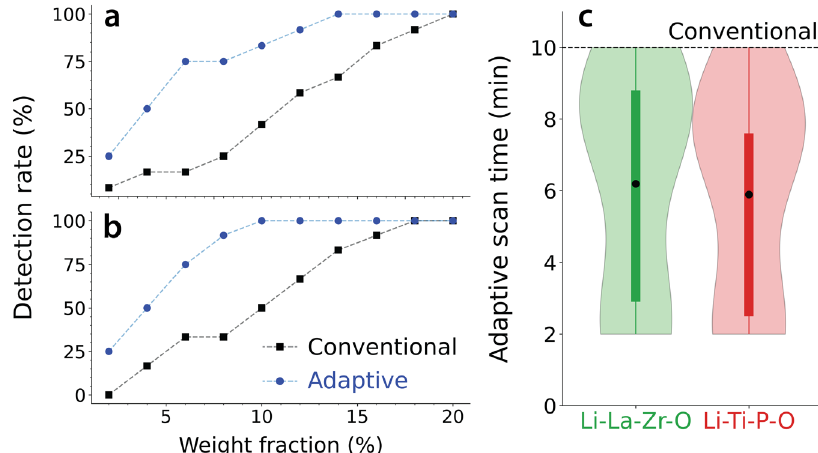
Fig. 3 Detection rates and measurement times required for impurity detection. a , b The percentage of minority phases that were correctly identi fi ed by XRD-AutoAnalyzer when applied to mixtures from the Li-La-Zr-O and Li-Ti-P-O chemical spaces, respectively. Results are plotted separately for predictions based on conventional and adaptive measurements. c The distributions of scan times required by adaptive measurements in each space. Each violin plot illustrates the density of scan times and spans the range of the data. In contrast, the embedded boxes extend only from the lower to upper quartiles. Black dots represent the average scan time required in each case. For comparison, the conventional scan time (10 min) is represented by the black dashed